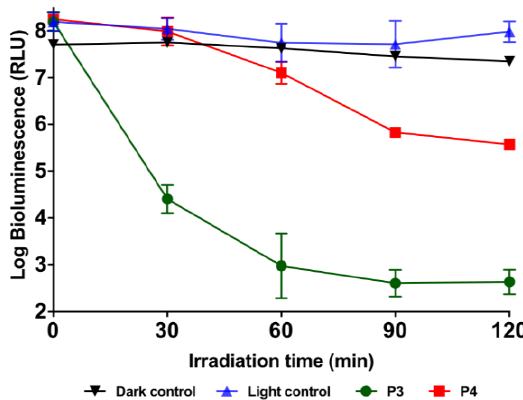
Figure 9. Photoinactivation of bioluminescent E. coli in the presence of P3-P4 at the concentration of 5.0 µ M under 3.0 mW cm − 2 of white light irradiation. The values represent the mean of three independent experiments with three replicates and the error bars indicate the standard deviation.